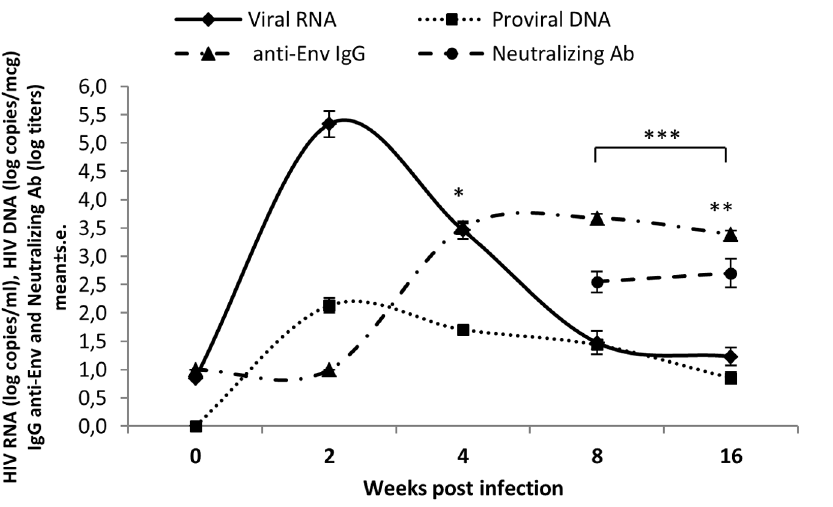
Figure 1. Dynamics of viral infection in 21 cynomolgus monkeys inoculated with SHIV SF162P4cy during acute (2–4 weeks p.i.), post- acute (8–16 weeks p.i.) of infection. Data represent mean values with standard error of log plasma RNA load, log proviral DNA, IgG anti-Env Ab, and nAb from 0 to 16 weeks p.i. (*) week 4: anti-Env bAb titers correlated positively with viral load (p=0.0002); (**) week 16: nAb titers correlated positively with anti-Env bAb titers (p=0.0041); (***) post-acute phase: proviral DNA levels correlated positively with anti-Env bAb (p=0.0225) and negatively with nAb titers (p=0.0083).